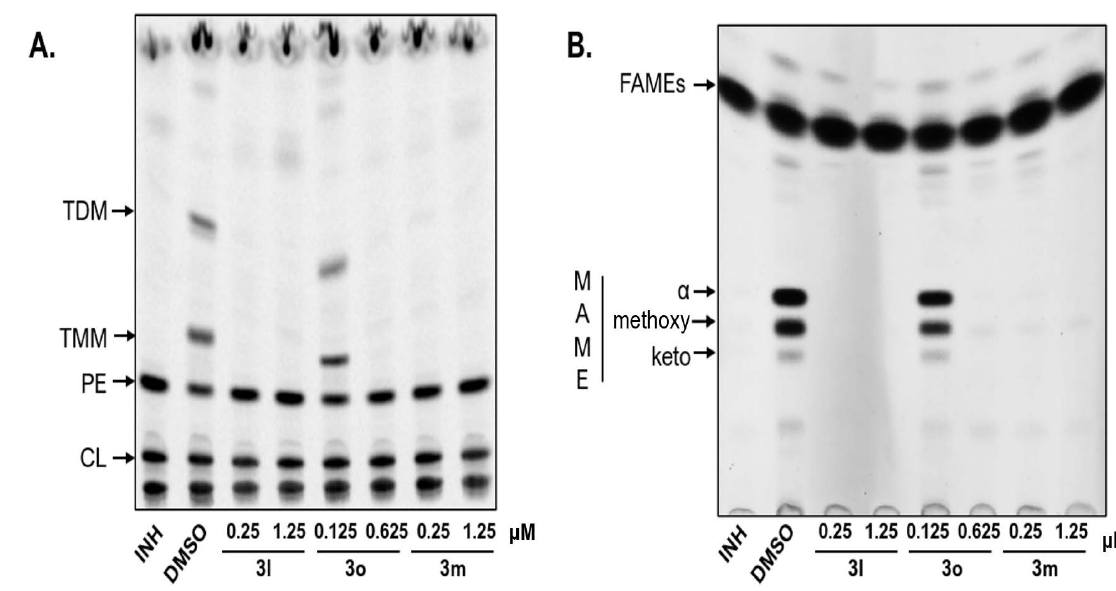
Figure 2. Autoradiogram of TLC analysis of ( A ) lipids and ( B ) fatty and mycolic acids methyl esters from 14 C labelled cells of Mtb . H 37 Ra treated with tested compounds or DMSO or INH as a control. Lipids were separated in chloro- form/methanol/water (20:4:0.5) and different forms of methyl esters were separated in n- hexane/ethyl acetate (95:5; 3 runs). INH: isoniazid; DMSO: dimethyl sulphoxide; TDM: trehalose dimycolates; TMM: trehalose monomycolates; PE: phosphatidylethanolamine; CL: cardiolipin; FAME: fatty acid methyl esters; MAME alpha-, methoxy- and keto- refer to the different forms of mycolic acids methyl esters.